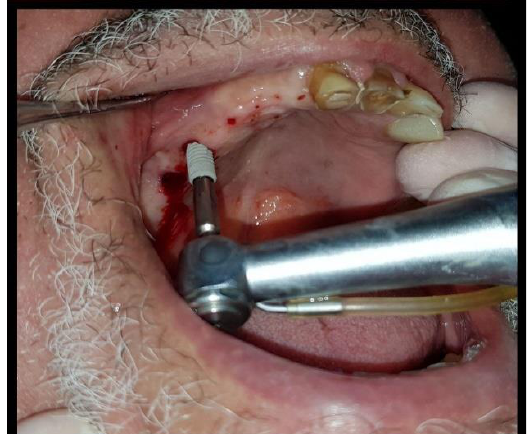
Figure 8: Final prosthesis was fixed in patient's